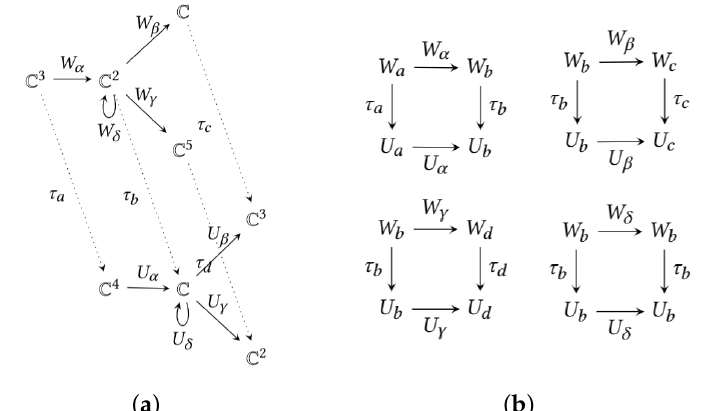
Figure 2. ( a ) A morphism of representations τ : W → U is given by a family of matrices τ = ( τ v ) v ∈V , such that τ a : C 3 → C 4 , τ b : C 2 → C , τ c : C → C 3 and τ d : C 5 → C 2 satisfy that τ b W α